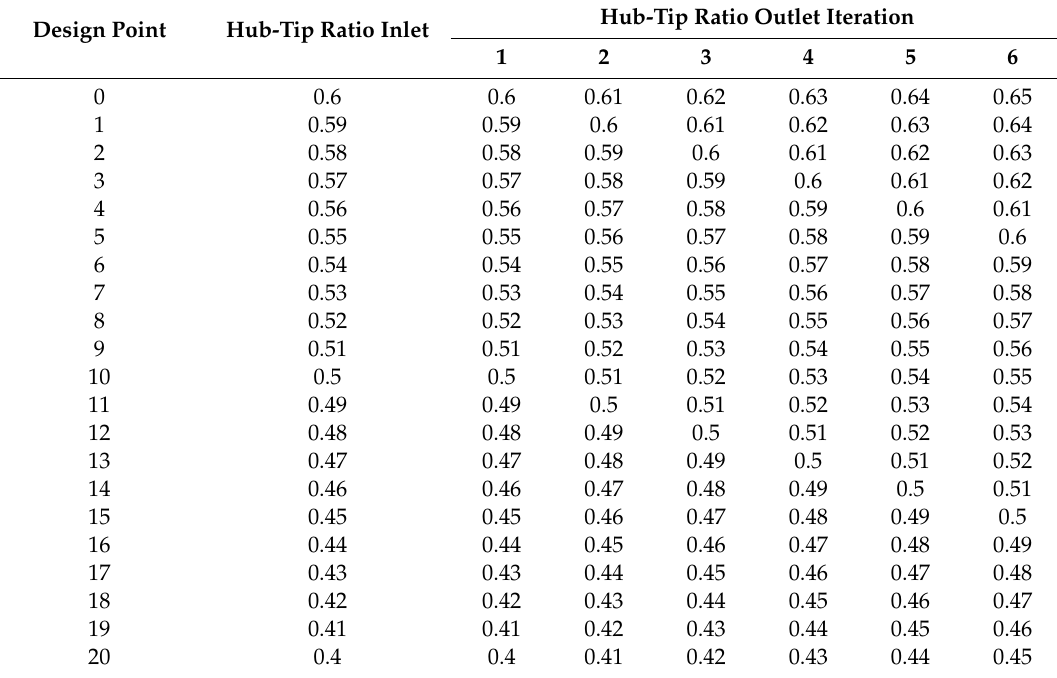
Table 7. Iteration procedure for the meanline analysis of the annulus outer diameter 0.17 m.